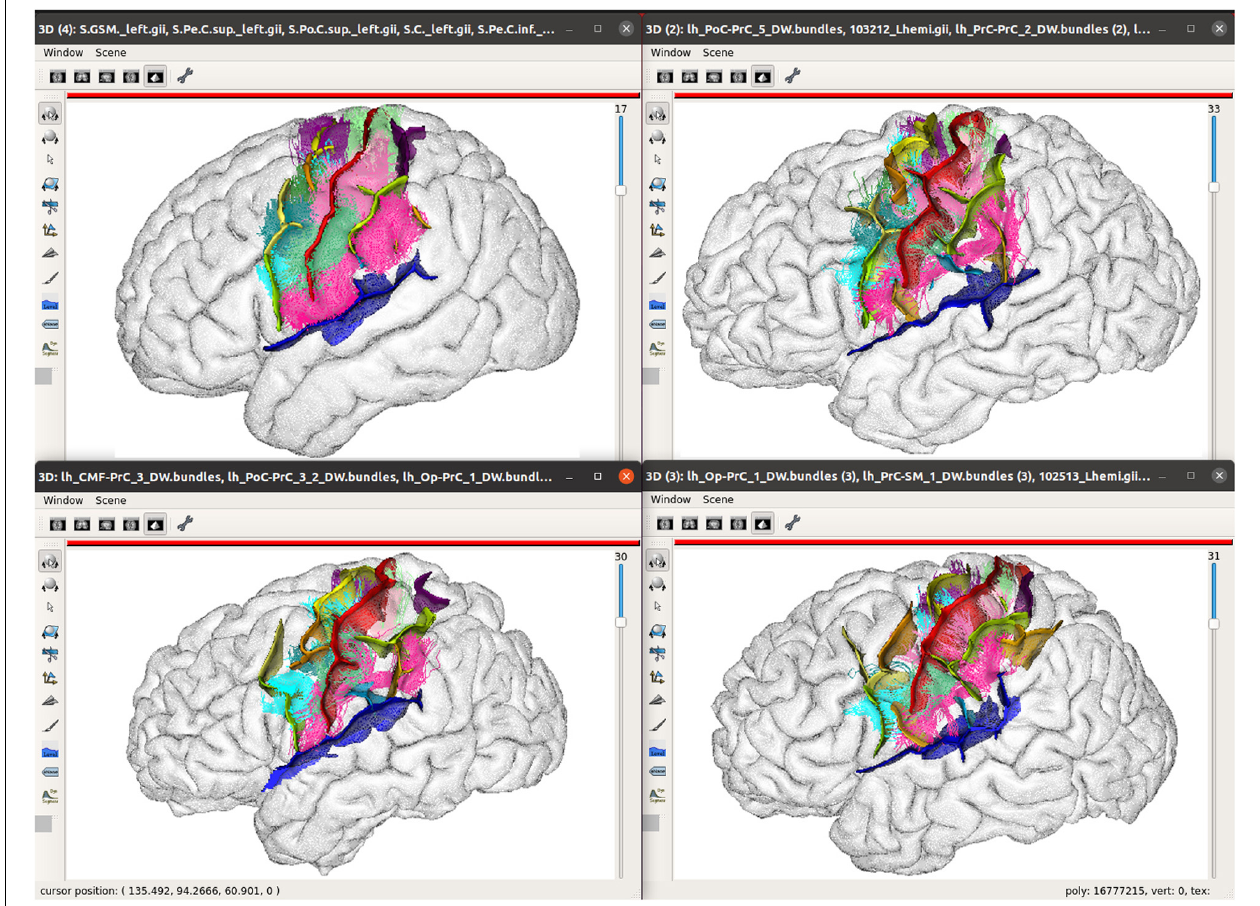
FIGURE 6 | Multimodal structural atlas browsing; A subset of sulcal graphs and labeled fiber bundles are displayed simultaneously for three different subjects and an average model in a selected region of the brain. The top left view displays the sulci computed from the average icbm152 MRI using Morphologist and a few of the short bundles of an 80-subject atlas (Labra et al., 2019). The other views show instances of the sulcus and bundle structural atlases in 3 individual subjects, each in its individual native space. Sulcal and bundles data are displayed with nomenclatures, which are used to identify the same structures across subjects, and assign colors to them. Hemisphere brain meshes are displayed in a wireframe mode, here, to allow a better visualization of the fiber trajectories, which circumvent the